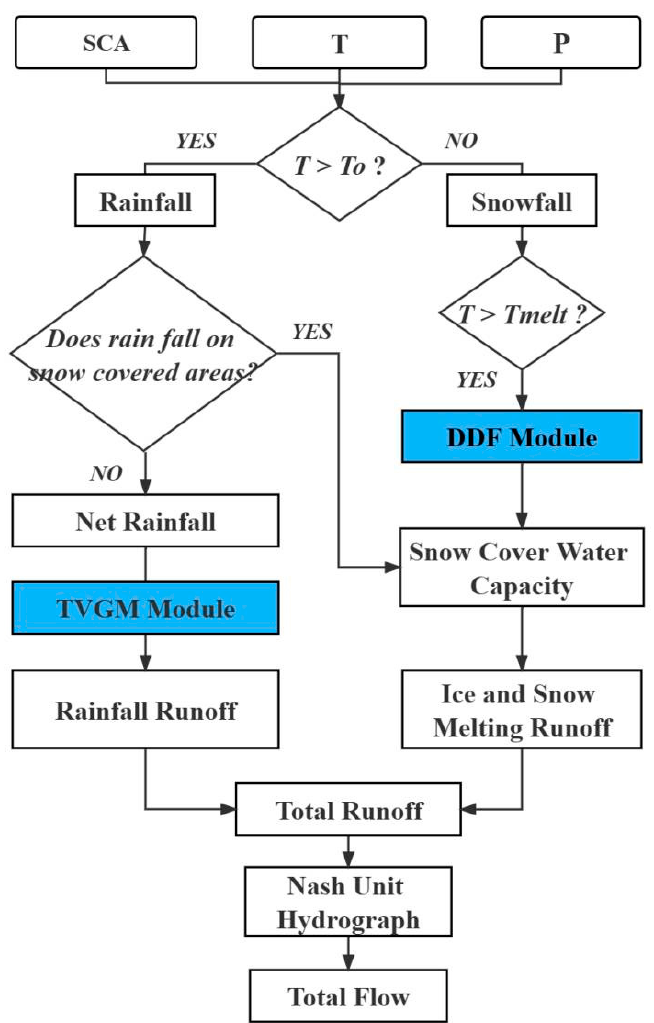
Figure A1. Flow chart of the TVGM-DDF model. Notes: SCA, T and P represent Snow-Covered Area, temperature and precipitation, respectively; T 0 represents the critical temperature of solid–liquid separation; and T melt represents the melting-point threshold temperature.